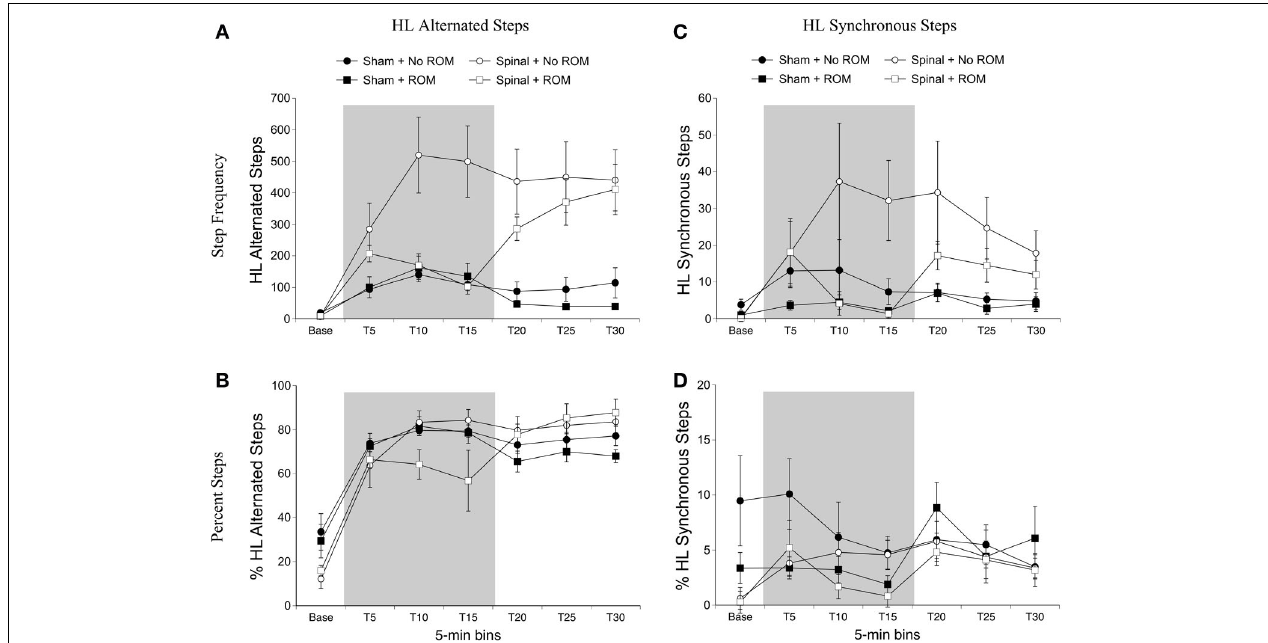
FIGURE 4 | Step frequency and percentage of hindlimb steps for sham and spinal P10 rats by ROM restriction condition. Frequency (A) and percentage (B) of alternated hindlimb steps, and frequency (C) and